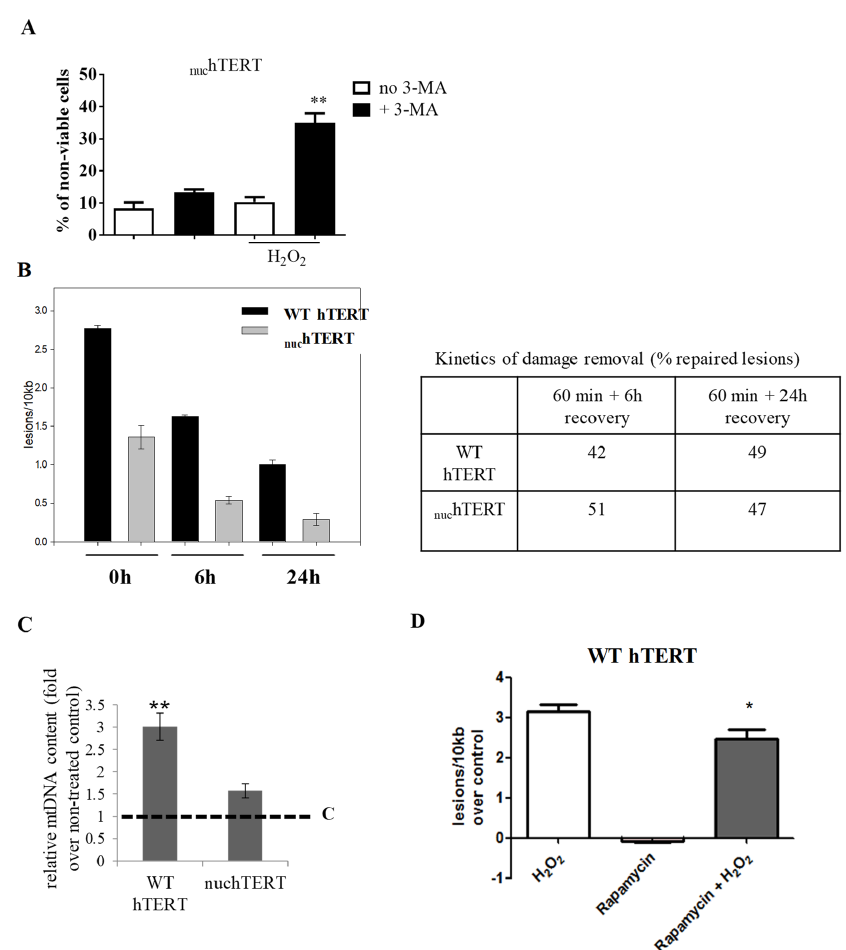
Figure 3. WT hTERT accumulates more mtDNA that nuc hTERT-expressing cells upon oxidative stress. ( A ) The nuc hTERT cells were pretreated with the autophagy inhibitor 3-MA for 48 hours and then treated with 60 minutes H 2 O 2 . In addition, the cells were allowed to recover for an additional 24 hours in condition media with and without the presence of 3-MA. Cell viability was determined by PI and flow cytometry. Graph represents mean of four separate biological experiments ± SEM. Student t-test was performed comparing the vehicle (no 3MA) + H 2 O 2 to its respective control and 3MA + H 2 O 2 to 3MA + no H 2 O 2 . Statistical significance was determined at a p value < 0.01**. ( B ) WT and the nuc hTERT cells were exposed to 200 µM of H 2 O 2 for 60 minutes and then allowed to recover for six and 24 hours. Total genomic DNA was isolated and the mtDNA integrity was analyzed. Data was normalized to mtDNA copy number. The results represent the mean of three experiments. ( C ) Total genomic DNA was extracted from WT hTERT and nuc hTERT non-treated or immediately following 60 minutes H 2 O 2 treatment when mtDNA content was analyzed. Graphs show average data from three independent biological experiments ± SEM. Student t-test compared mtDNA content at 60 minutes as compared to non-treated control. Statistical significance was determined at p value < 0.01**. The dotted line represents non-treated control. ( D ) Quantification of mtDNA damage per 10 kb DNA by QPCR. WT hTERT expressing cells were exposed to 200 µM of H 2 O 2 for 60 minutes in the presence or absence of the autophagy modulator rapamycin . The samples were pretreated for one hour with rapamycin and then exposed to H 2 O 2 (H 2 O 2 + rapamycin) for an additional hour. Graphs show an average from four independent experiments ± SEM. Student t-test compared levels of mtDNA detected in the rapamycin